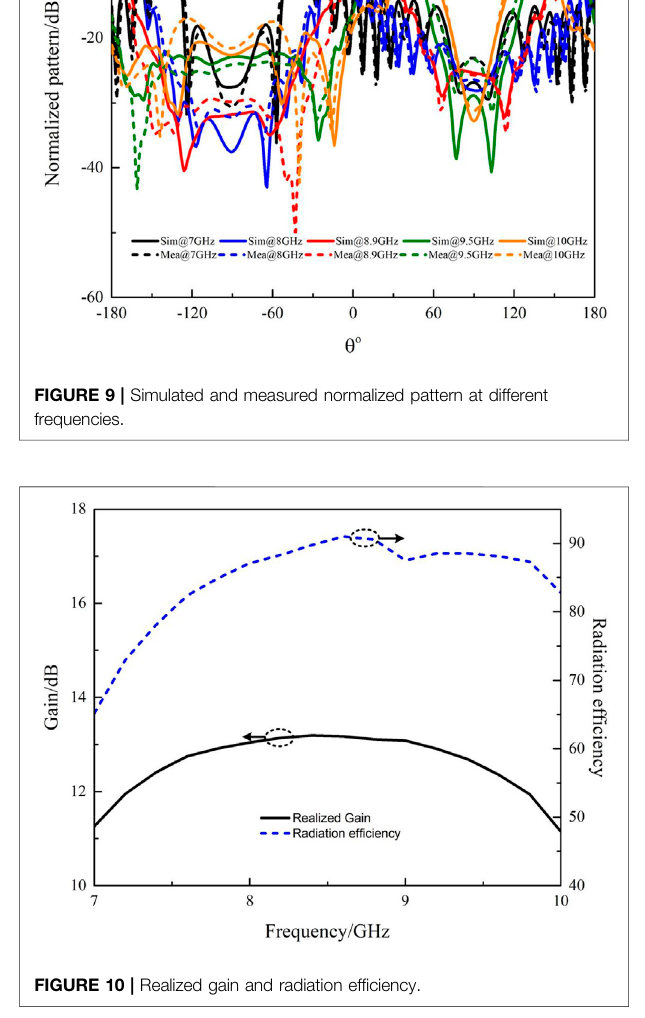
Figure 10 . The gain keep stable at around 12 dB within the